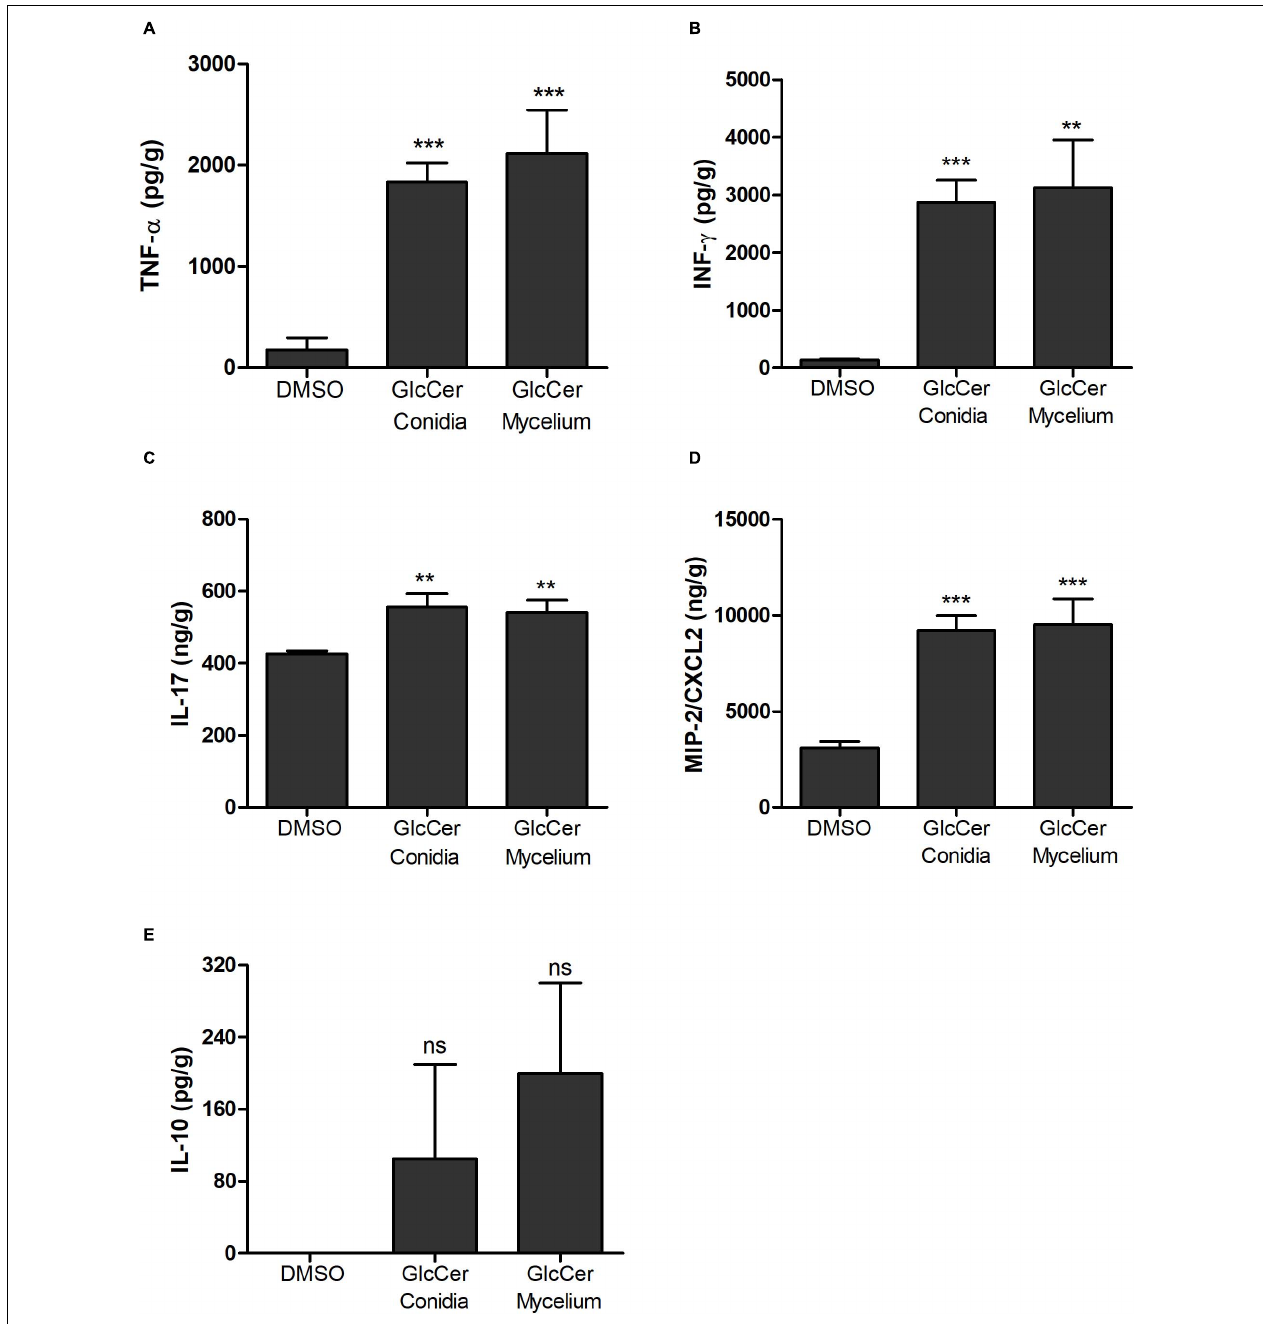
FIGURE 8 | Cytokine detection in spleens from mice 24 h after GlcCer species injection. The pro-inflammatory cytokines analyzed were: (A) TNF- α ; (B) INF- γ ; (C) IL-17; (D) MIP2/CXCL2; and anti-inflammatory cytokine (E) IL-10. Each group was injected with 200 µ g of mycelium or conidia form, and as a control 0.5% of DMSO in PBS. ∗∗ p < 0.005; ∗∗∗ p < 0.0001; ns, no